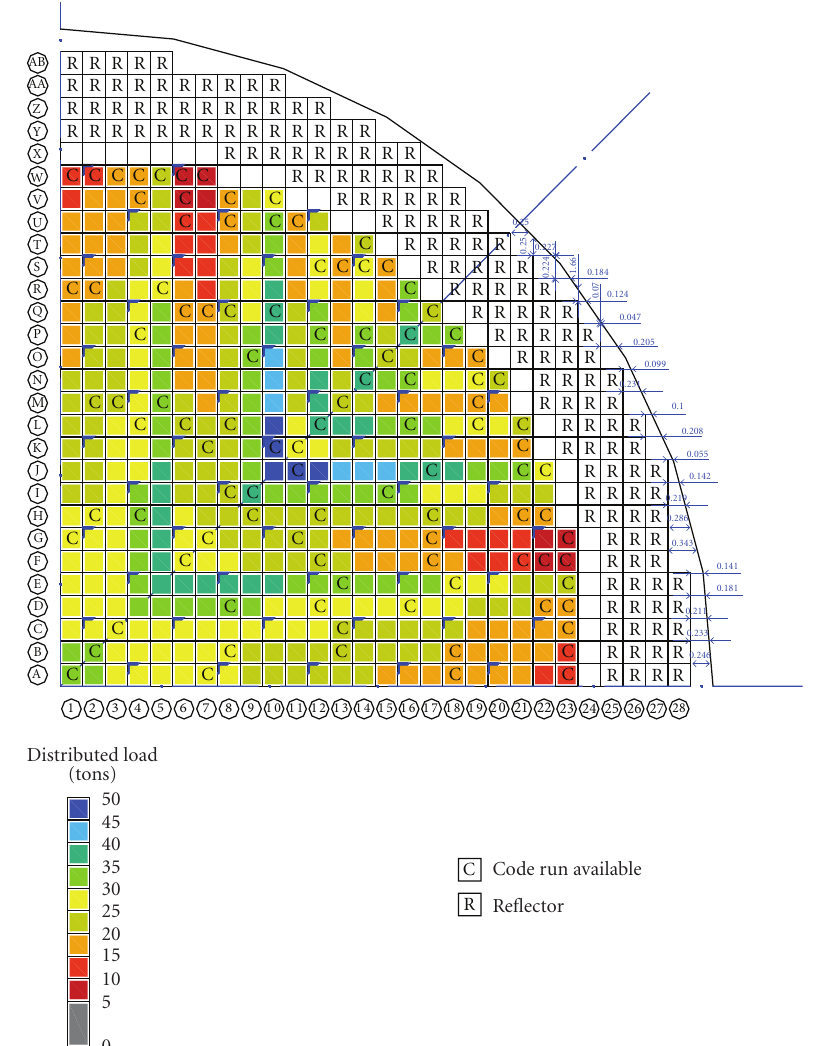
Figure 3: Results from calculating mechanical loads on neighboring channels due to the rupture of an assigned pressure